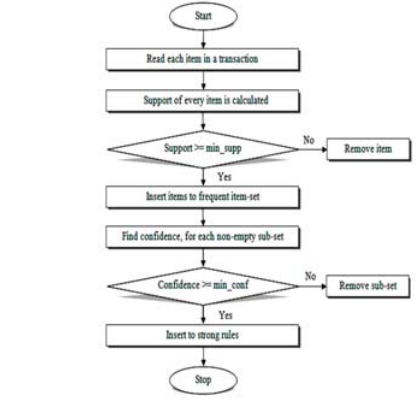
Fig. 1. Flow chart of apriori